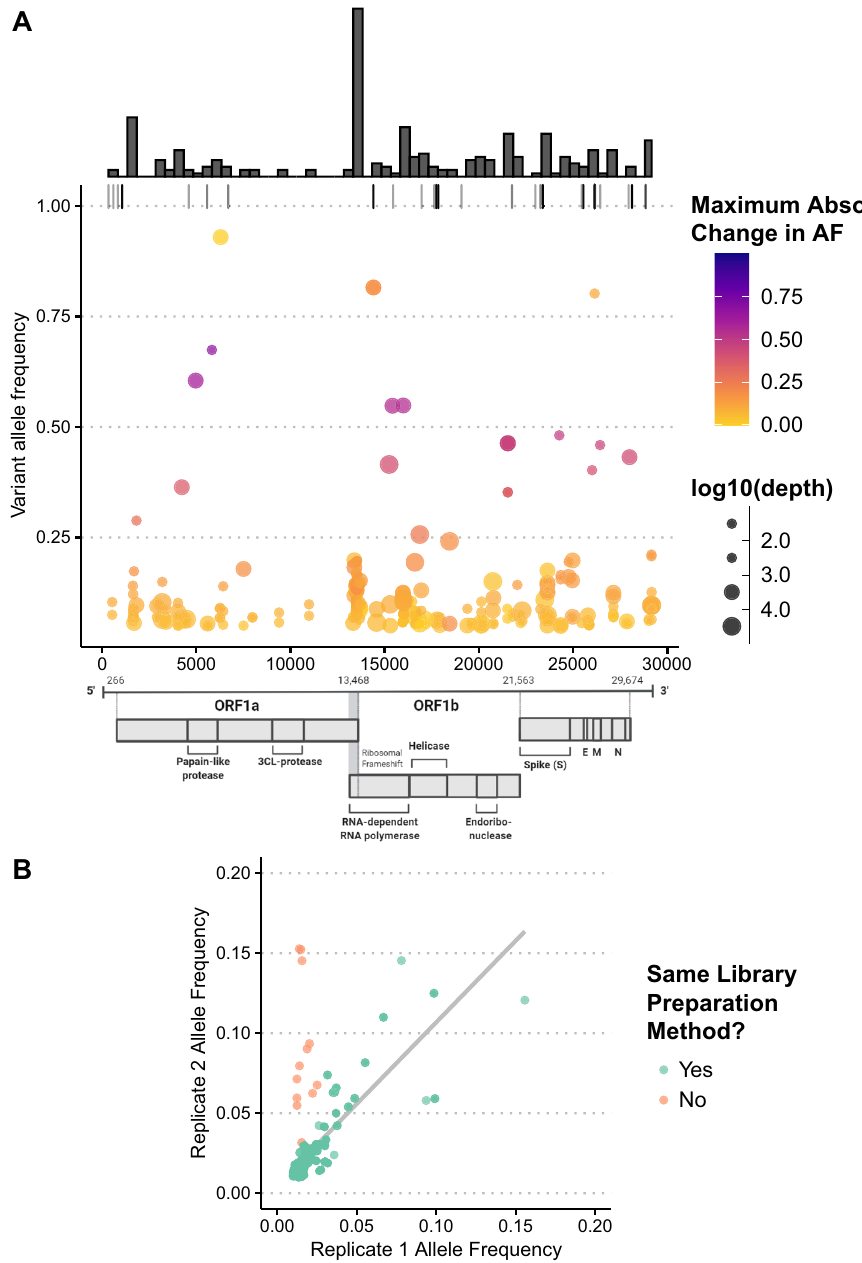
Figure 2. Low frequency variation is abundant but only a small number of variants exhibit a significant change in allele frequency over the course of infection. ( A ) Each dot represents a high-confidence coding change in a single sample relative to the Wuhan-Hu-1 (NC_045512.2) reference genome with variant allele frequency between 5 and 95%, at least ×100 coverage at the site, and reproducibility in multiple samples at lower frequencies (< 40%). Color scale represents the change in allele frequency across time points in the same patient with darker colors representing variants that had greater changes in frequency across samples. Small dark grey marks along the top margin shows positions with variant frequencies > 95% (fixed mutations relative to the reference). Size of circles indicates sequencing depth at the site. Marginal histogram shows distribution of variants using bin width of 500 nucleotides. ( B ) Comparison of allele frequencies of low-frequency variants (< 20%) across replicates of the same sample (n = 10 samples). Each dot represents a variant with ≥ 100 total depth and ≥ 10 allelic depth in each replicate. Line of best fit is shown in purple, and dots in orange represent replicates that were re-sequenced using a different library preparation method (amplicon sequencing vs. shotgun metagenomic